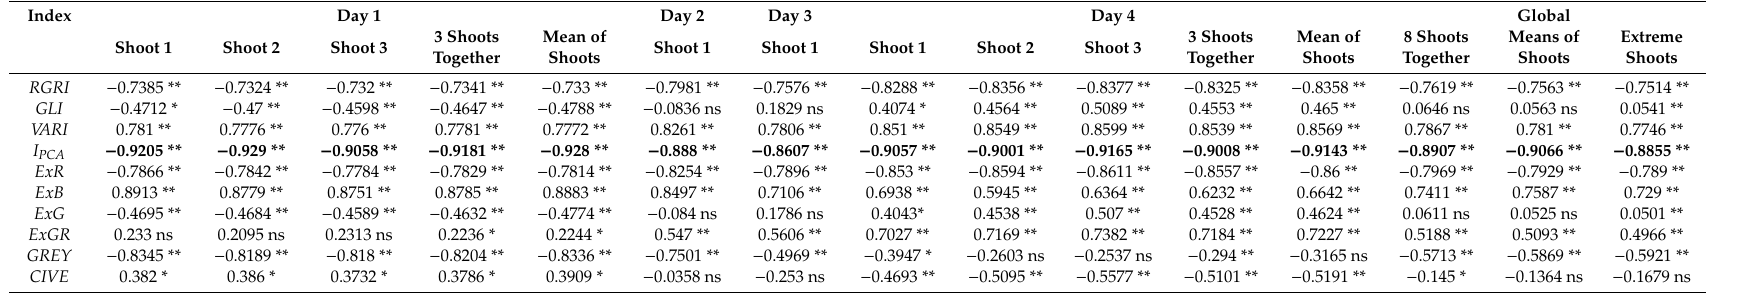
Table 4. Correlation coe ffi cients for indices studied for di ff erent researchers. Results are given for each individual shoot, for daily values on days #1 and #4 (taking into account the three shoots altogether or the mean values of the three shoots) and for global datasets. The latter include data from all the days using the eight shoots, data from all the days using mean values for days #1 and #4 and mean values between extreme shoots (the darkest shoot from day #1 and the brightest shoot from day #4). The highest R-values are highlighted in bold typeface. Significance levels: ** ( p < 0.01) and * ( p <